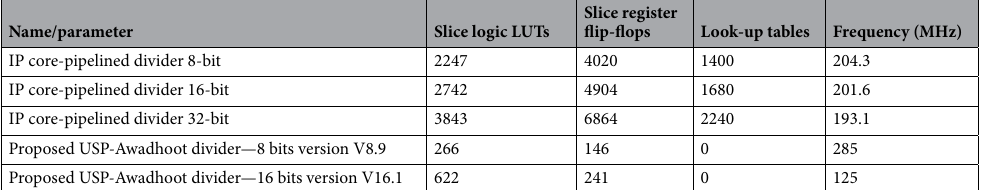
Table 4. Comparative analysis of the resource utilization of the proposed USP-Awadhoot algorithm-based divider with that of the Xilinx IP core-pipelined divider.